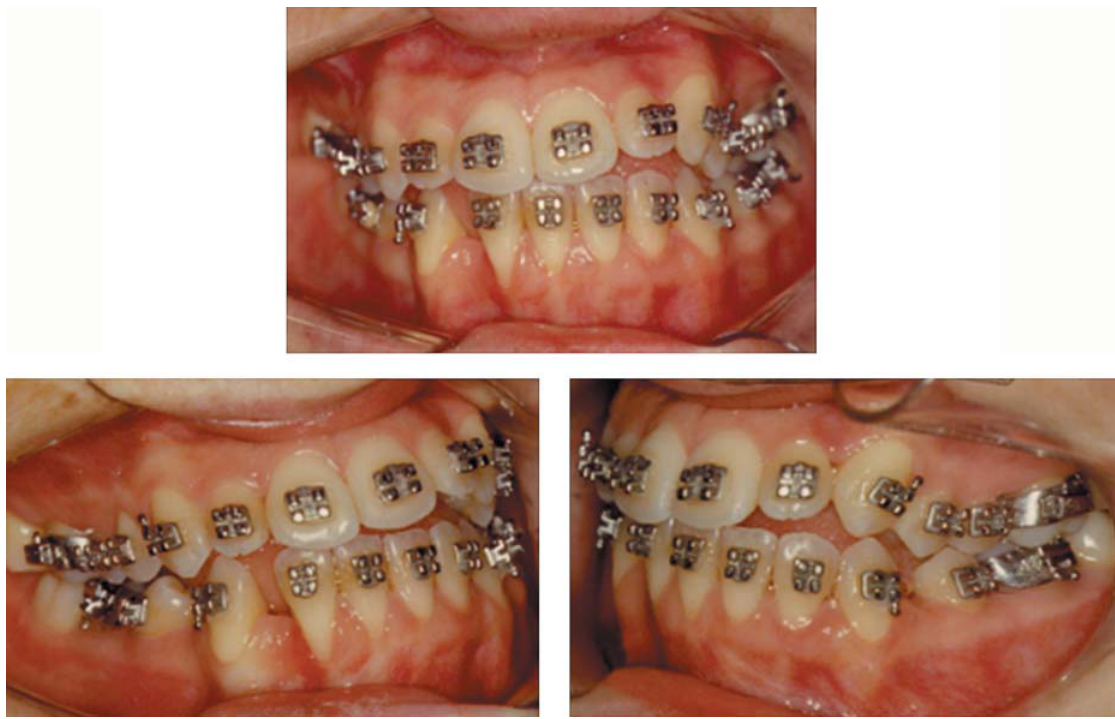
FIGURE 5- Correcting the anterior dental cross-bite after mandibular premolar